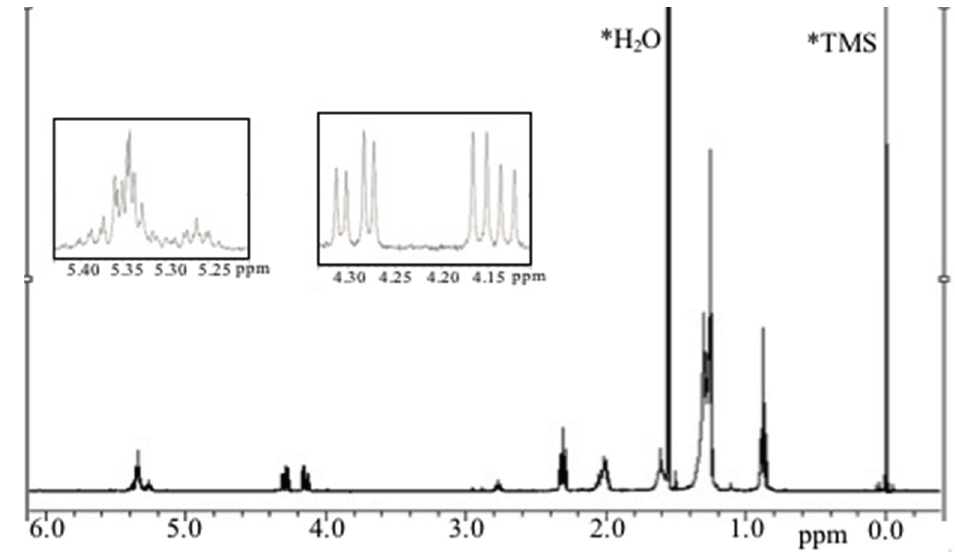
Figure 6. 1 H NMR of M12b lipidic fraction in CDCl 3